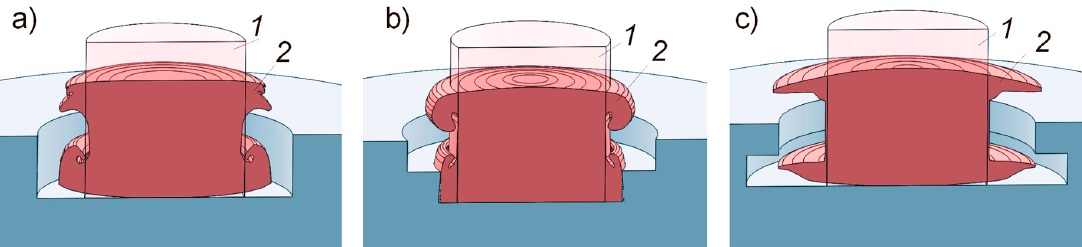
Figure 15. Initial, 1, and final, 2, shape of the workpiece in the die cavity in the processes: ( a ) CC; ( b ) FC; and ( c ) JF.